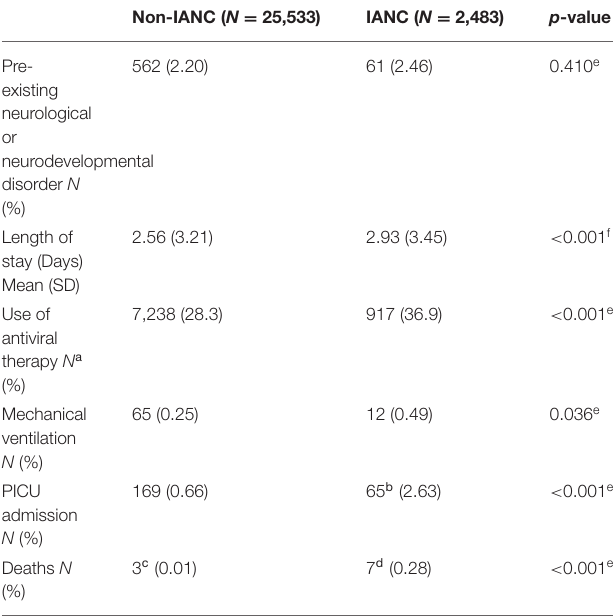
TABLE 2 | Comparison of the clinical characteristics and burden of hospitalised influenza admission with neurological complications (IANCs) and those without neurological complications (Non-IANC) between 2014 and